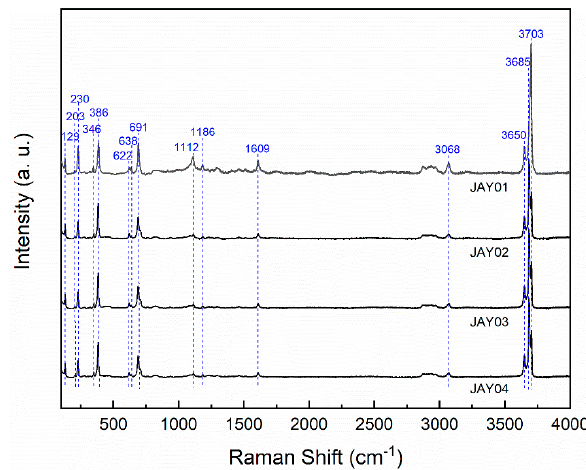
Figure 8. Raman spectra (in the range of 100–4000 cm − 1 ) of the nearly Fe-free and Al-free antigorites (Mg 6 Si 4 O 10 (OH) 8 ) found in jianite. Note that the Raman spectra from different samples (labeled with the text next to the spectrum) are almost identical.